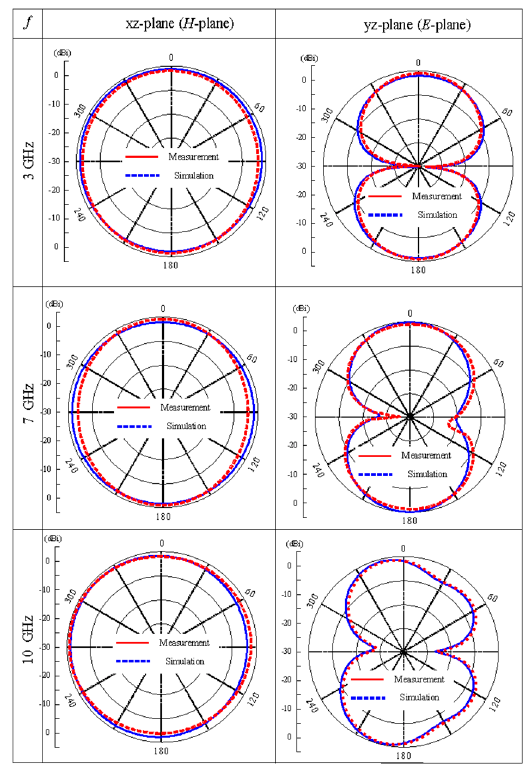
Figure 16. Simulated measure radiation pattern in E-and H-plane radiation pattern at 3, 7, and 10 GHz.